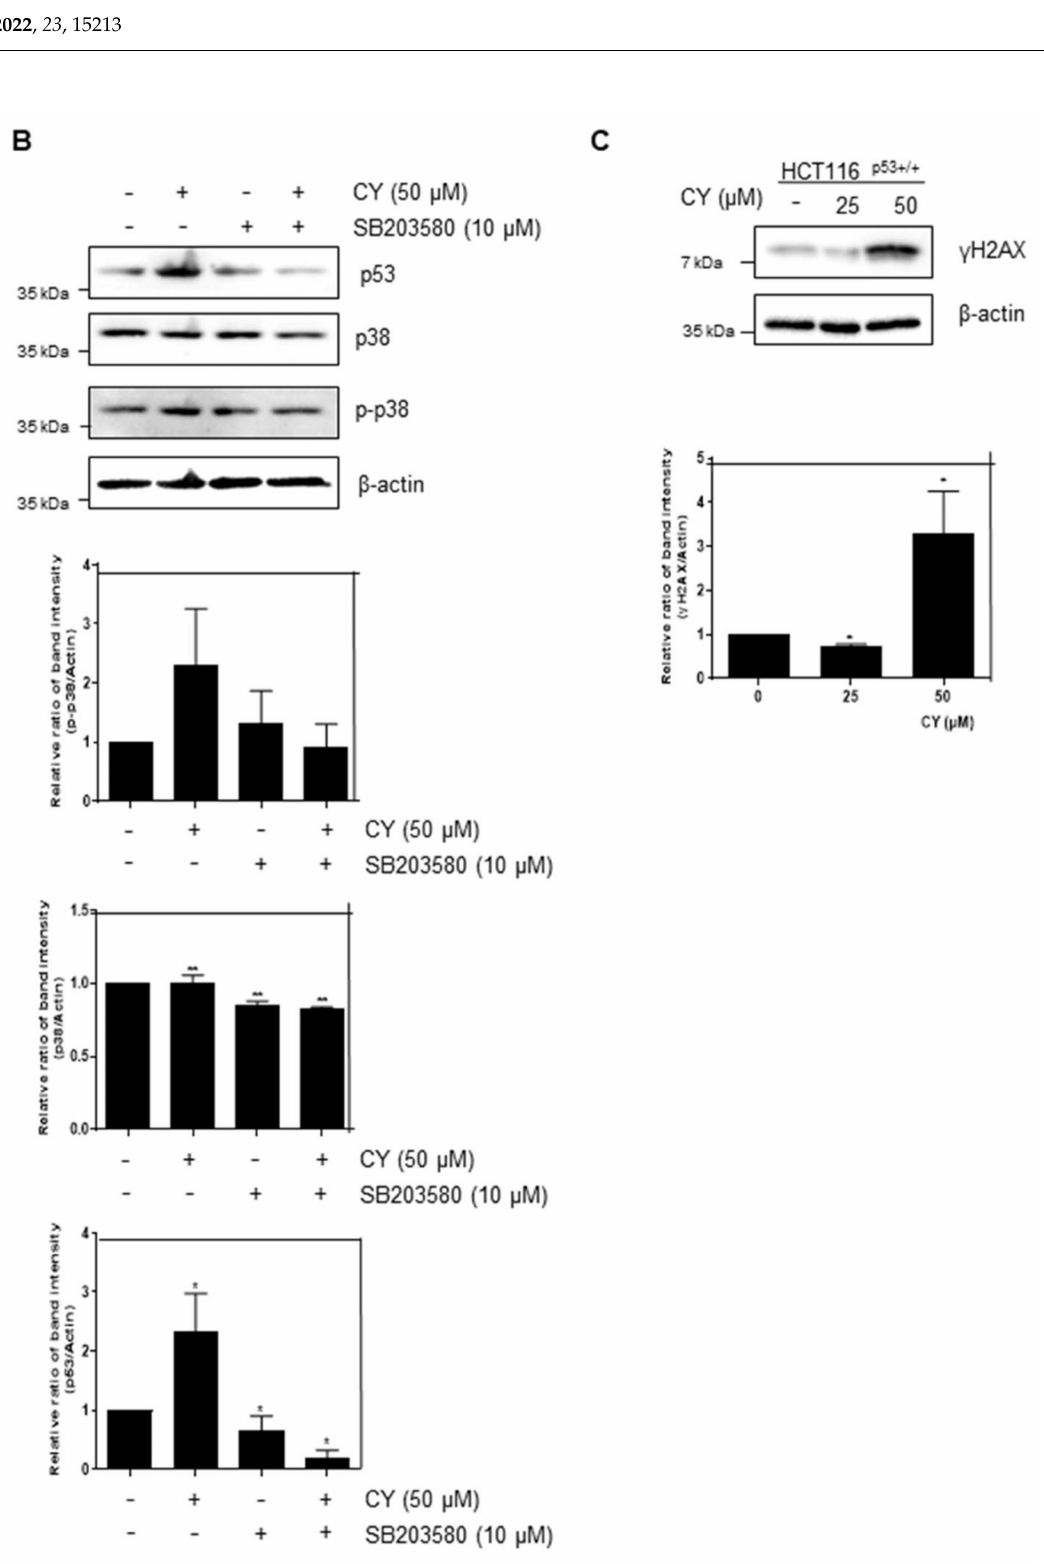
Figure 9. Effect of CY on expression of MAPKs and DNA damage in HCT116 p53+/+ cells. ( A , C ) HCT116 p53+/+ cells were treated with 50 µ M CY at concentration 0, 25, 50 µ M subjected to Western blotting for p-JNK, JNK, p-ERK, ERK, p-p38, p38, H2AX and β -actin antibodies. ( B ) HCT116 p53+/+ cells were treated with 10 µ M of SB203580 for 1 h before CY 50 µ M for West- ern blotting with p53, p-p38, p38 and β -actin antibodies. Ratio of each protein was determined by Image J. * p < 0.05. ** p <